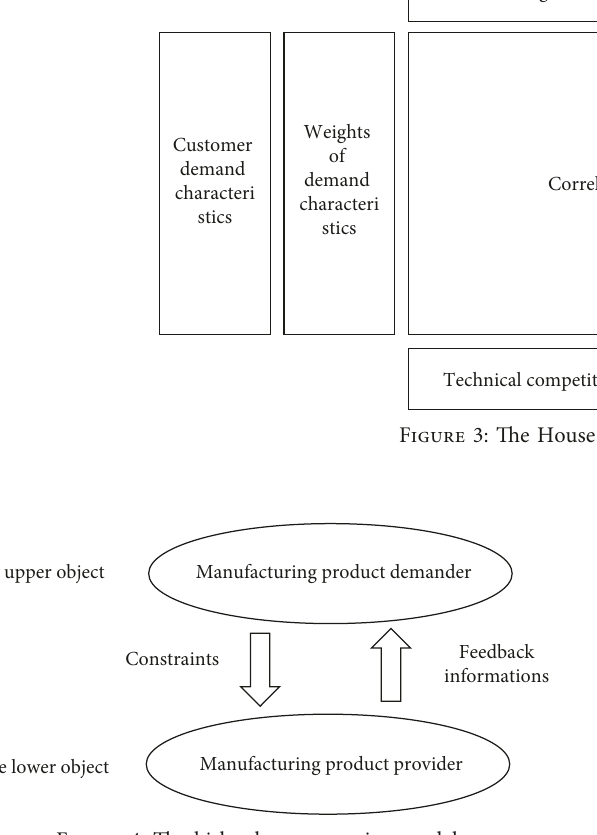
Figure 4: The bi-level programming